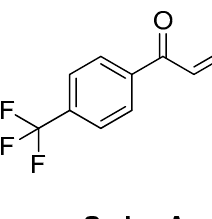
Figure 2. Structures of selected drugs containing one or more fluorine atoms.